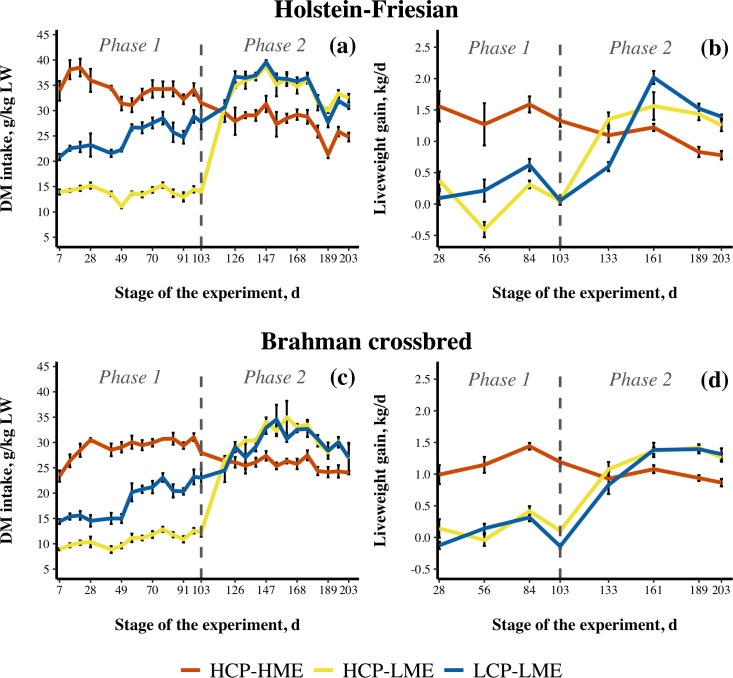
Dry matter (DM) intake and liveweight gain of Holstein-Friesian (a and b) and Brahman crossbred (c and d) steers fed high crude protein and high metabolizable energy content (HCP-HME), high CP and low ME content (HCP-LME) and low CP and low ME content (LCP-LME) diets throughout the experiment. The different nutritional treatments were imposed from day 1 until day 103 (Phase 1), after that all steers were fed HCP-HME ad libitum until day 203 (Phase 2). Dashed grey line represents the transition from Phase 1 to Phase 2. Error bars represents standard error of the mean.